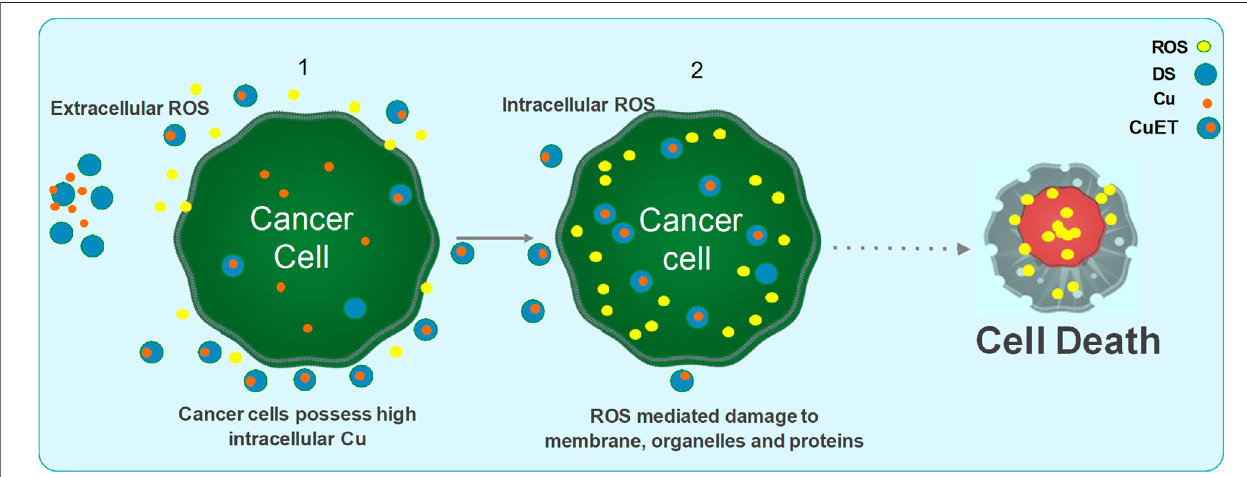
FIGURE 3 | Mechanism of action of DSF/Cu induced anticancer activity. DSF and Cu reaction generates extracellular ROS and damage the membrane proteins. The formation of CuET complex outside the cell and transportation of CuET through lipid bilayer, in addition to increased in fl ux of Cu via the CTR1 transporter, further triggers the intracellular ROS mediated mitochondrial damage and DNA damage leading to apoptosis via the MAPK pathway and JNK activation. CuET also inhibits the proteasomeactivity via theNPL4/p97segregasepathwayleadingtoinhibitionofNFkBpathway.DSFandCuETfurtherinhibitsALDHmediatedROSdetoxi fi cation and Pgp mediated drug ef fl ux mechanisms. Collectively, all the above negatively effects the cancer cell survival and maintenance of stemness and resistance thereby sensitizing the cells to ROS and anticancer drug mediated damage, eventually leading to